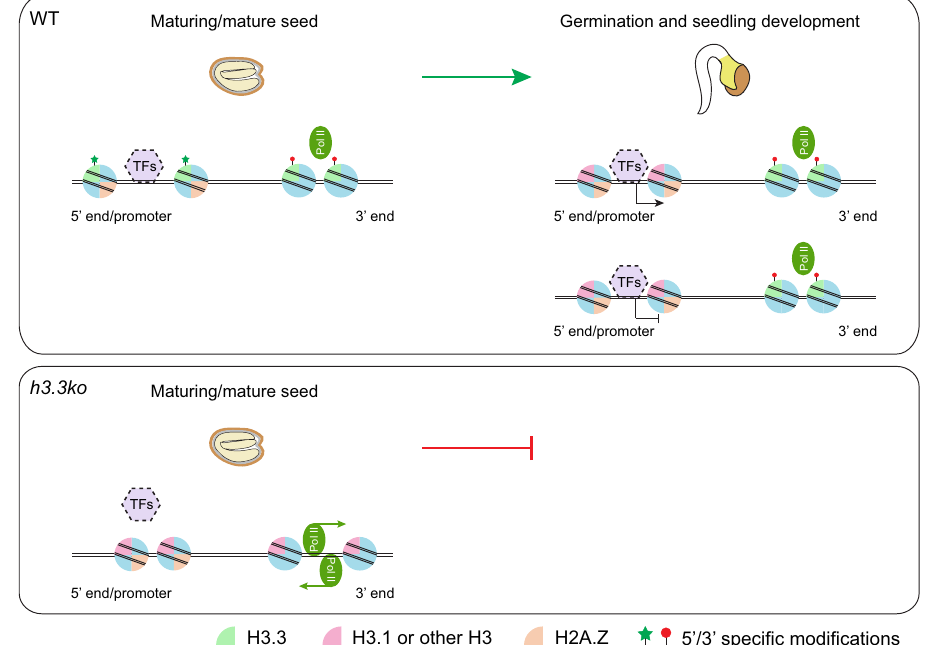
Fig. 7 | A proposed function of H3.3 in chromatin accessibility regulation. In maturing and mature seeds, H3.3 is loaded at the 5 ′ gene ends/promoters and establishes chromatin accessibility. During germination and seedling devel- opment, H3.3 is gradually removed from the 5 ′ gene ends, but the accessibility established by H3.3 is largely maintained probably by the binding of tran- scriptionfactors(asindicatedbythedashedborder),andthismayallowproper gene transcriptional regulation (activation or repression) during post-